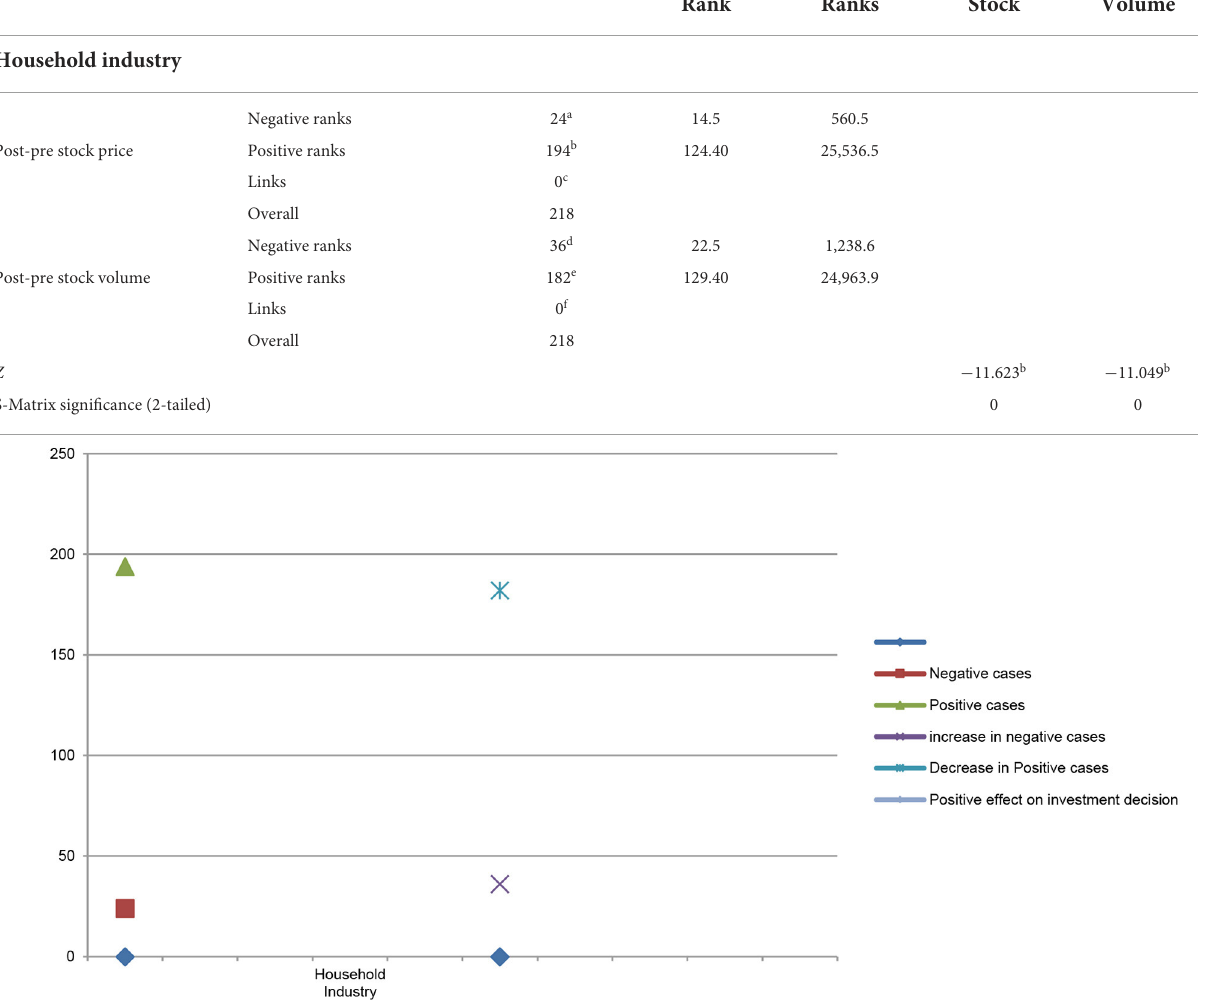
TABLE 6 Multiple regression of household